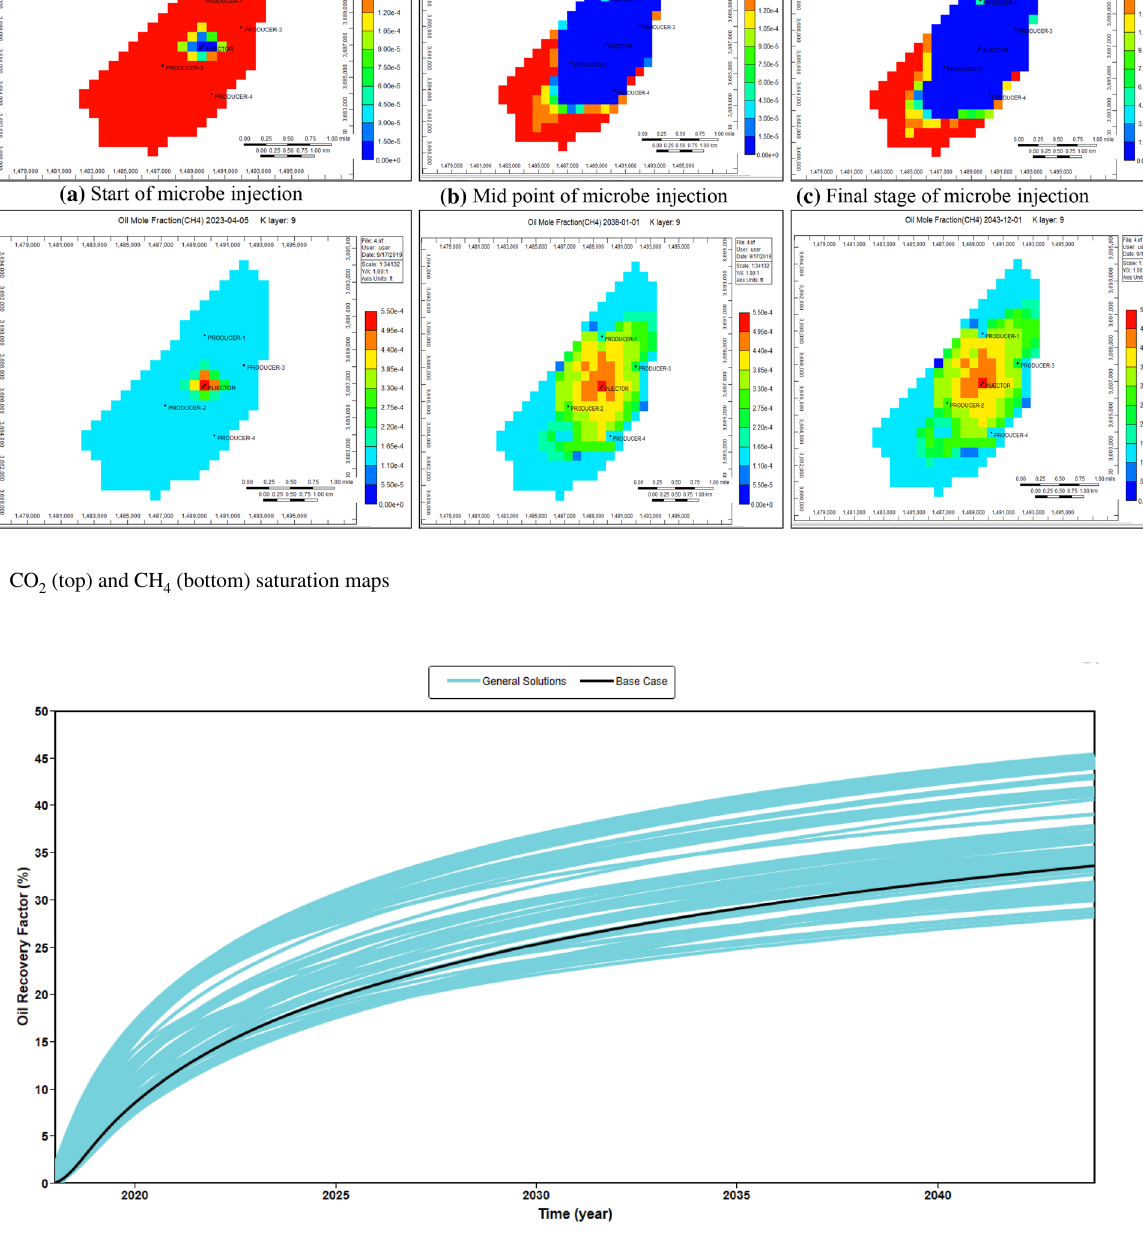
Fig. 19 Oil recovery in relation to different geological